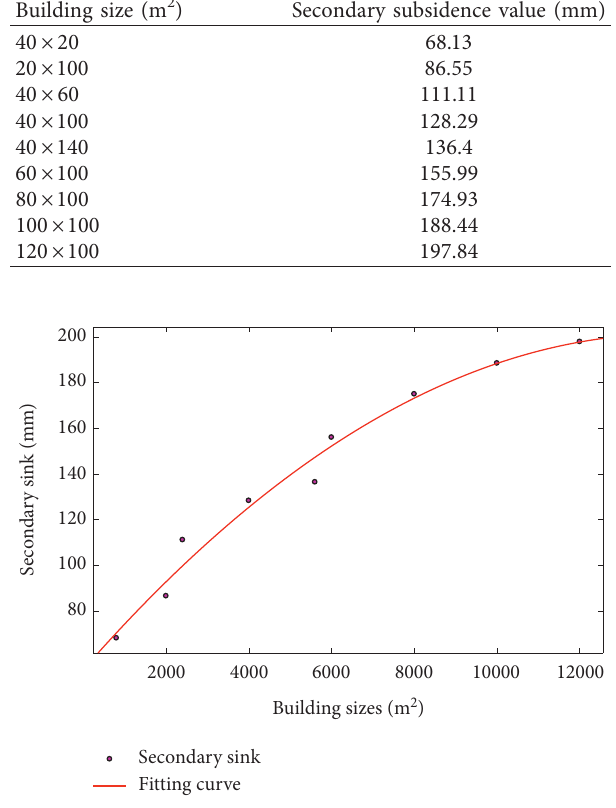
Figure 10: Fitting curve of building size and maximum surface secondary settlement. Table 7: Secondary sink in different building width-to-length ratios.